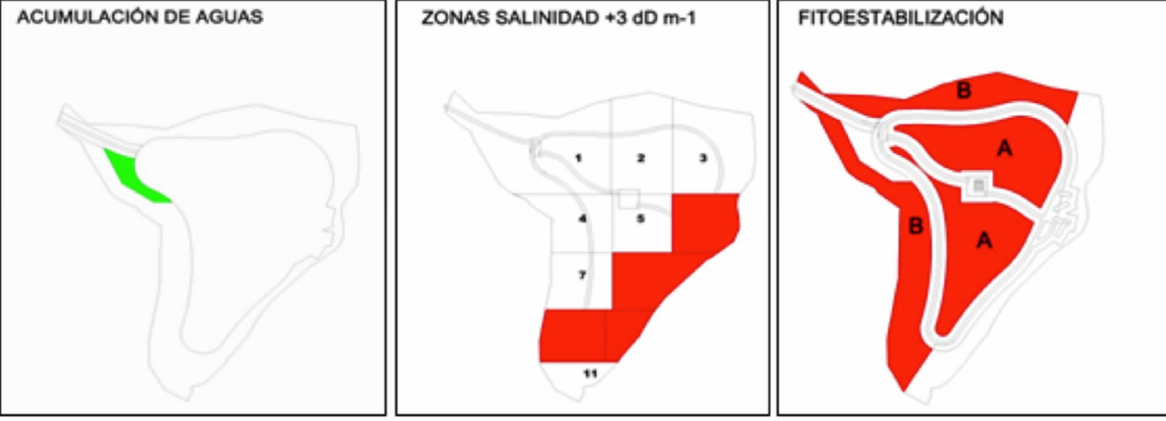
Figure A3. Characterization of areas with environmental problems, for Case Study